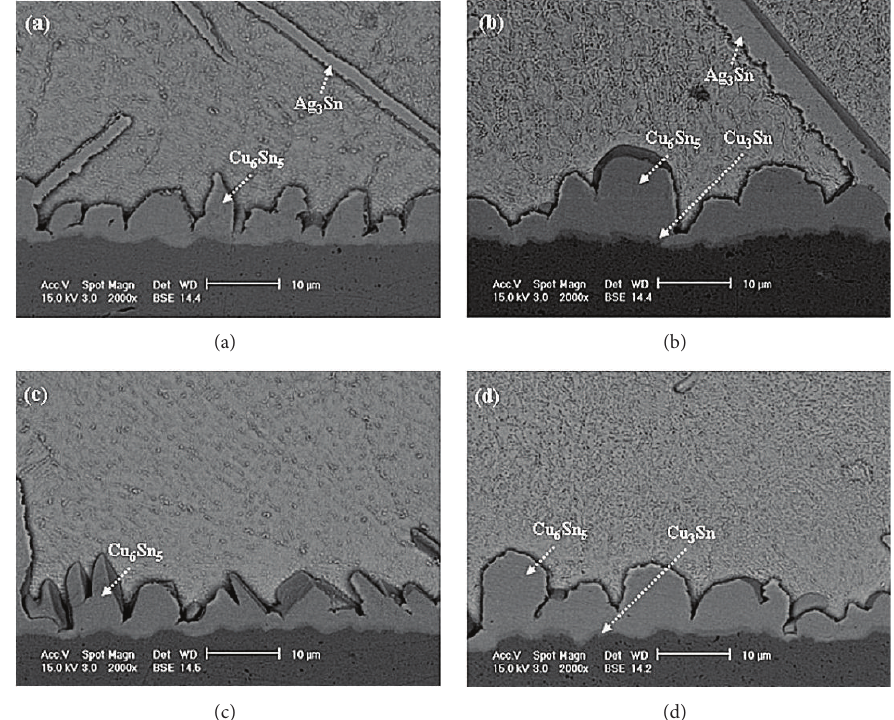
Figure 11: SEM micrographs of ((a) and (b)) SnAgCu and ((c) and (d)) SnAgCu-1TiO 2 solder joints on Ag metallized Cu pads after ((a) and (c)) 8 and ((b) and (d)) 16 reflow cycles